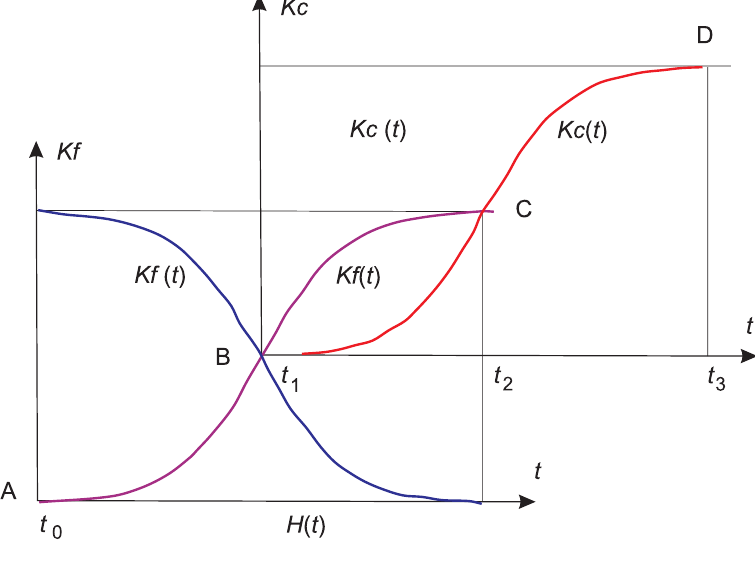
Fig. 1. Qualitative model of innovations